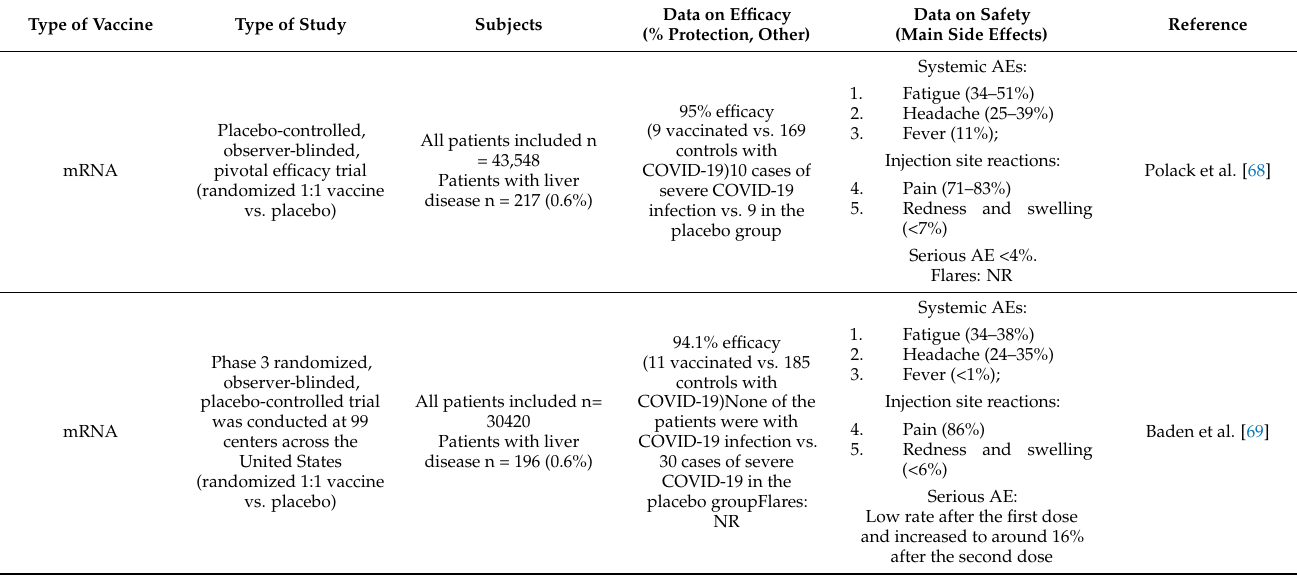
Table 2. Summarized COVID-19 vaccine studies on safety profile, efficacy, and adverse effects rate in patients with autoimmune liver